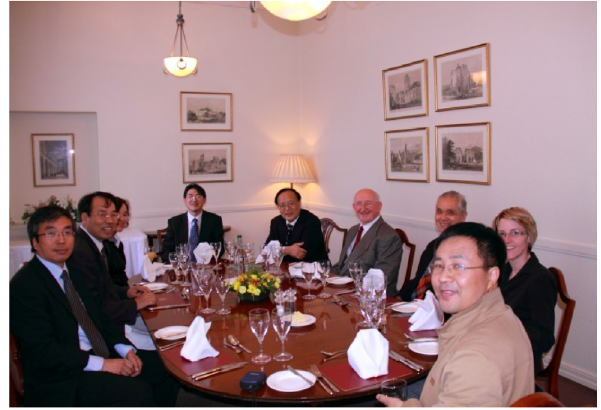
Fig. 1 Visit to the University of Leeds by some of the editorial board members of Friction , on 11 June